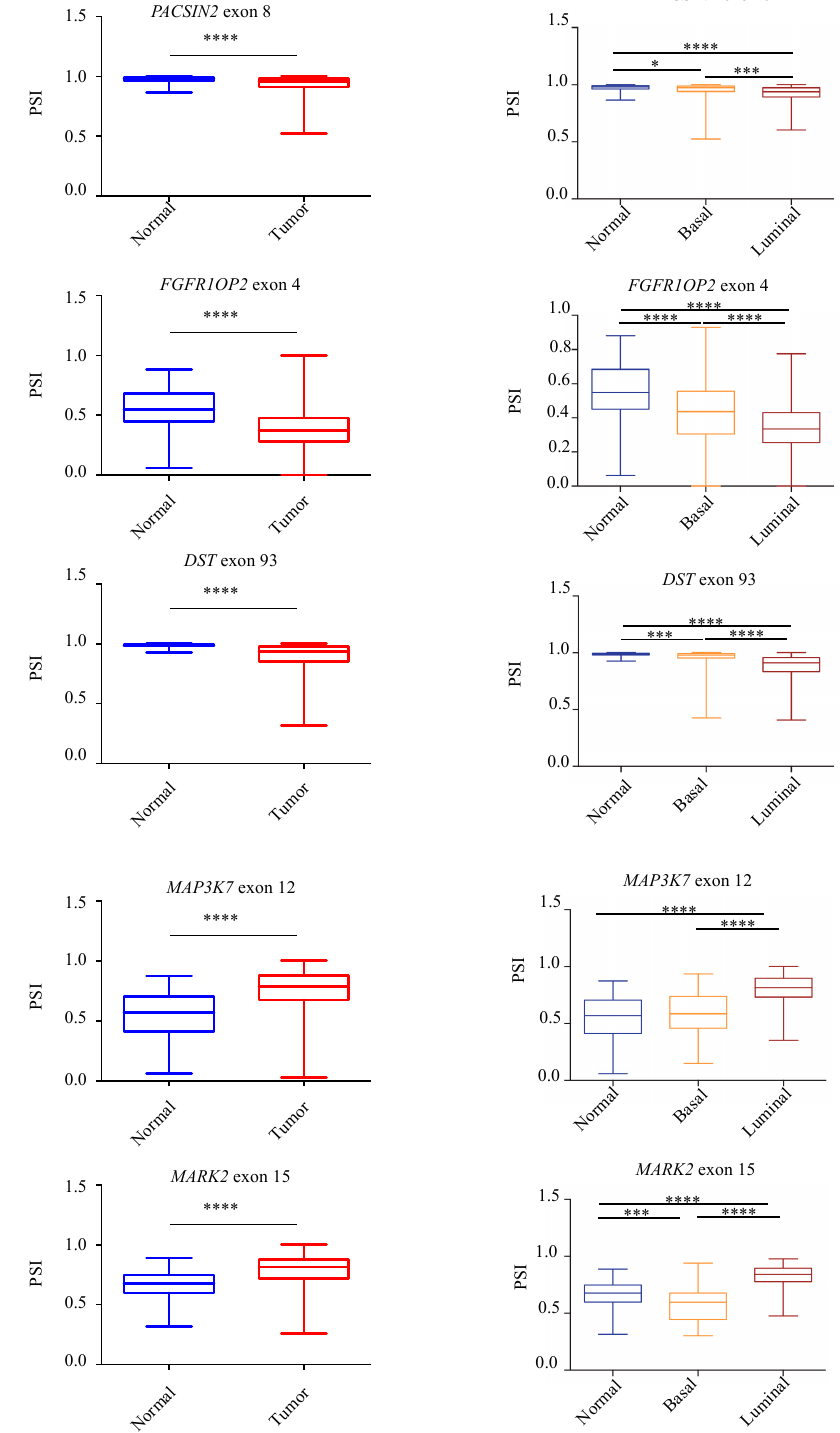
Figure 5. Validation of RASL-seq AS events in breast cancer specimens and in non-pathological tissues. Analysis, by using the TCGA SpliceSeq online tool, of the splicing pattern of ADD3 exon 13, PACSIN2 exon 8, DIAPH1 exon 2, FGFR1OP2 exon 4, MARK3 exon 16, DST exon 93, LMO7 exon 9, MAP3K7 exon 12, RBM5 exon 7, and MARK2 exon 15 in normal and primary tumor specimens from the TCGA-BRCA dataset (left) and in normal and primary tumor specimens divided for their histopathological state (basal or luminal) (right). PSI = Percent Splice-In. **** p < 0.0001, *** p < 0.001, * p <